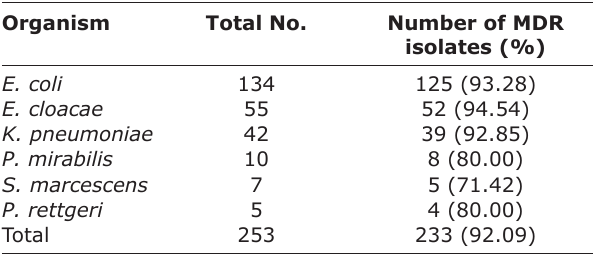
Table-1: MDR in Enterobacteriaceae isolates. Organism Total No.